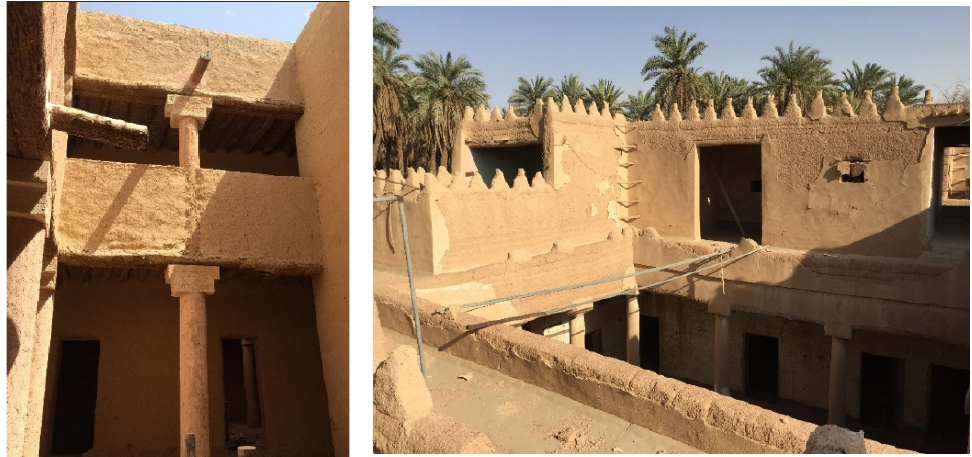
Figure 1. Sample of a traditional house in the Najd